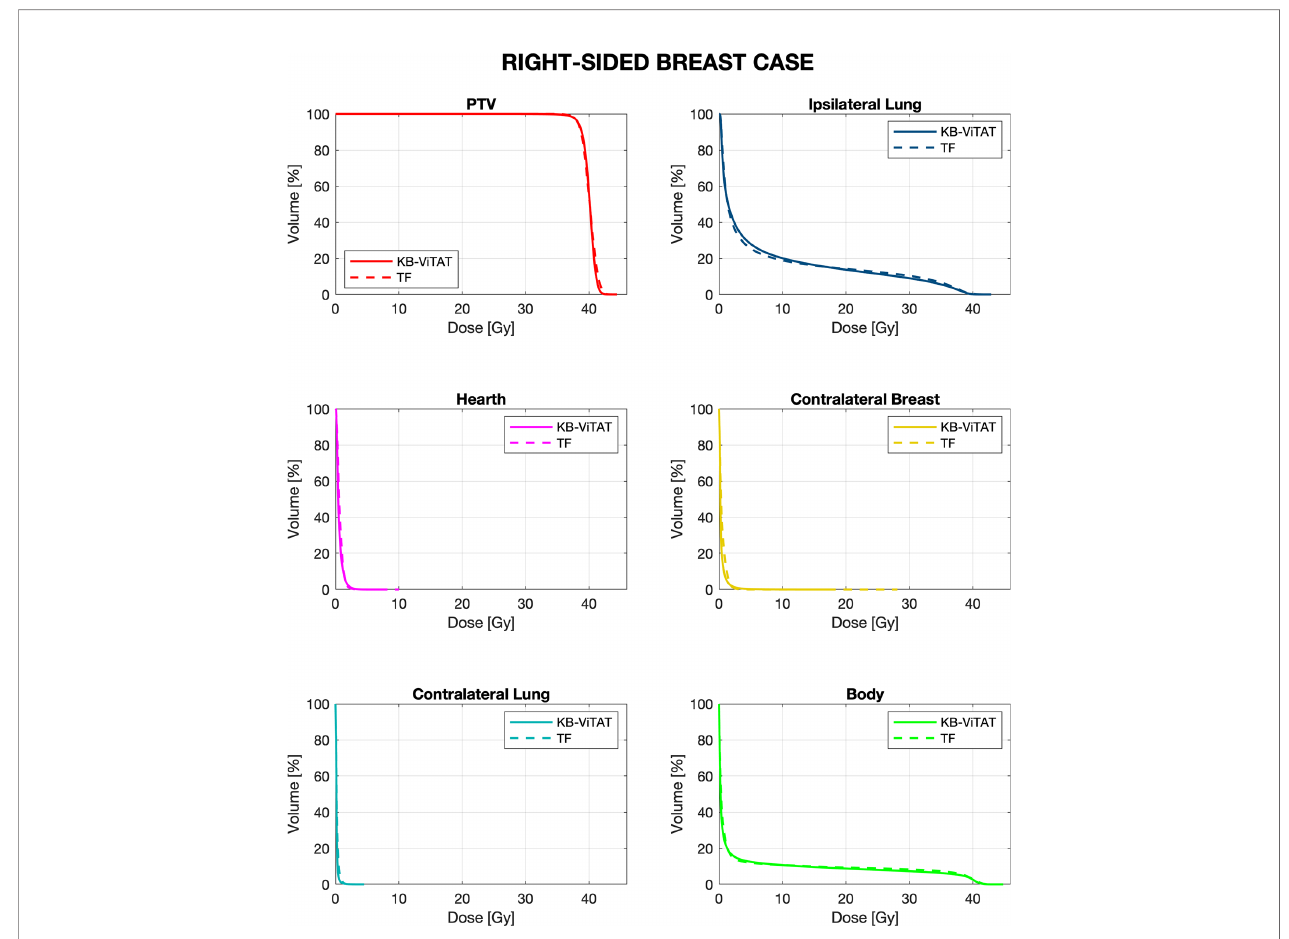
FIGURE 2 | Mean-DVH comparison of 30 right-sided breast patient tests between the original clinical TF (solid lines) and fully automatic KB-ViTAT (dashed lines) plans.